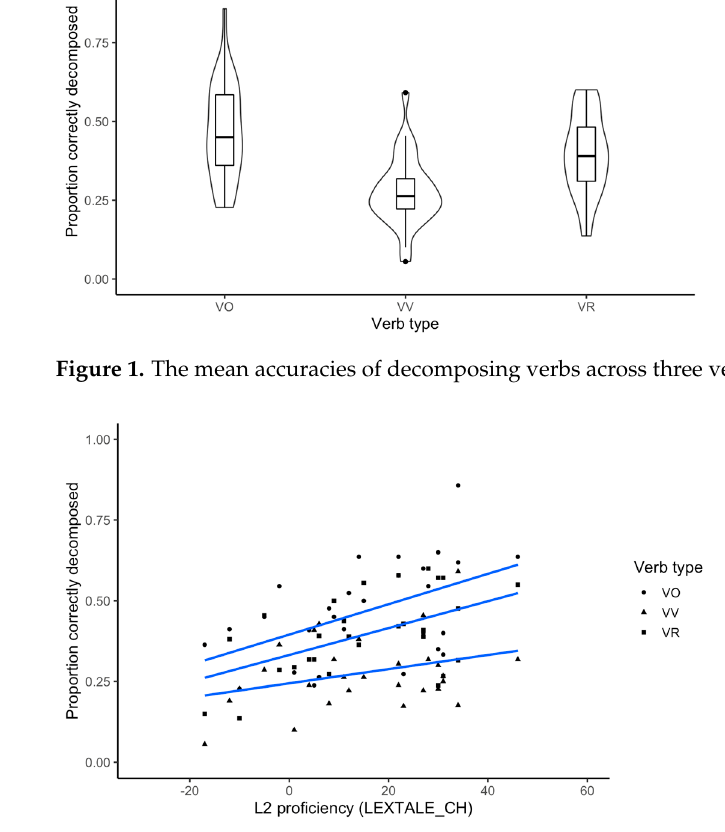
Figure 2. The mean accuracies of decomposing verbs across L2 proficiency.